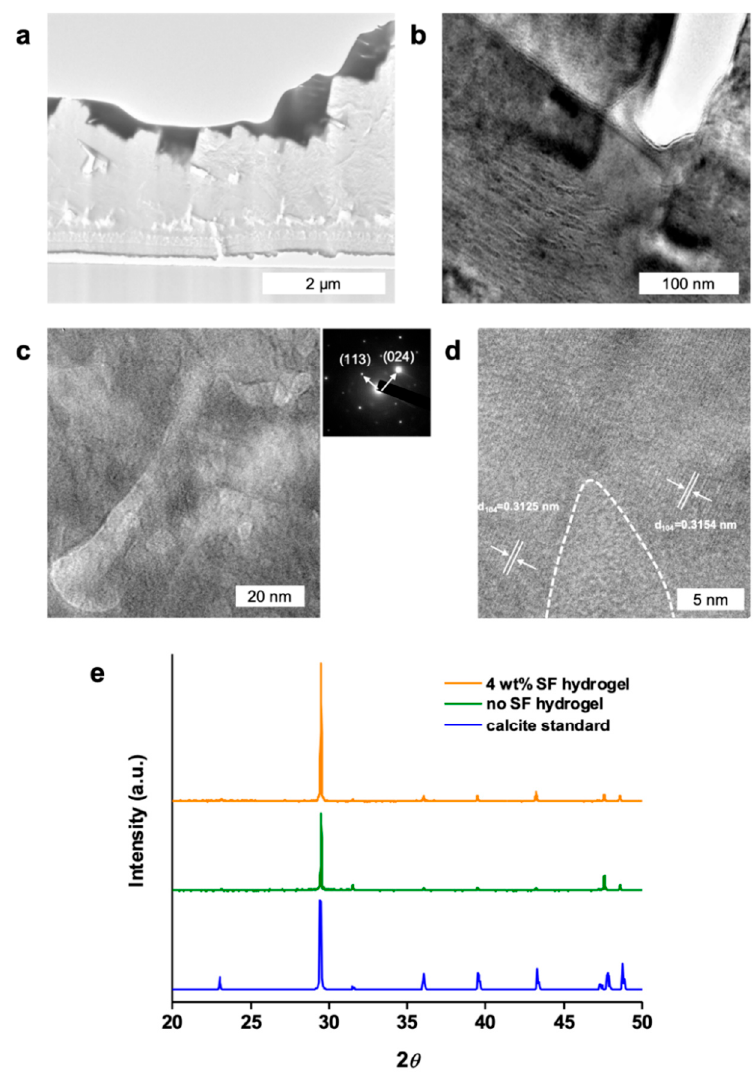
Figure 5. TEM ( a , b ) and high-resolution TEM ( c , d ) images of rhombohedral films prepared in 1 wt% SF hydrogel matrices. The selected area electron diffraction (SAED) pattern of the film is alongside an HR-TEM image ( c ). The sample for TEM measurements was treated with the focused ion beam technique. ( e ) XRD patterns of rhombohedral films obtained in the presence of 4 wt% SF hydrogels and in the absence of SF hydrogels, respectively, where the blue curve shows the standard XRD pattern of calcitic CaCO 3